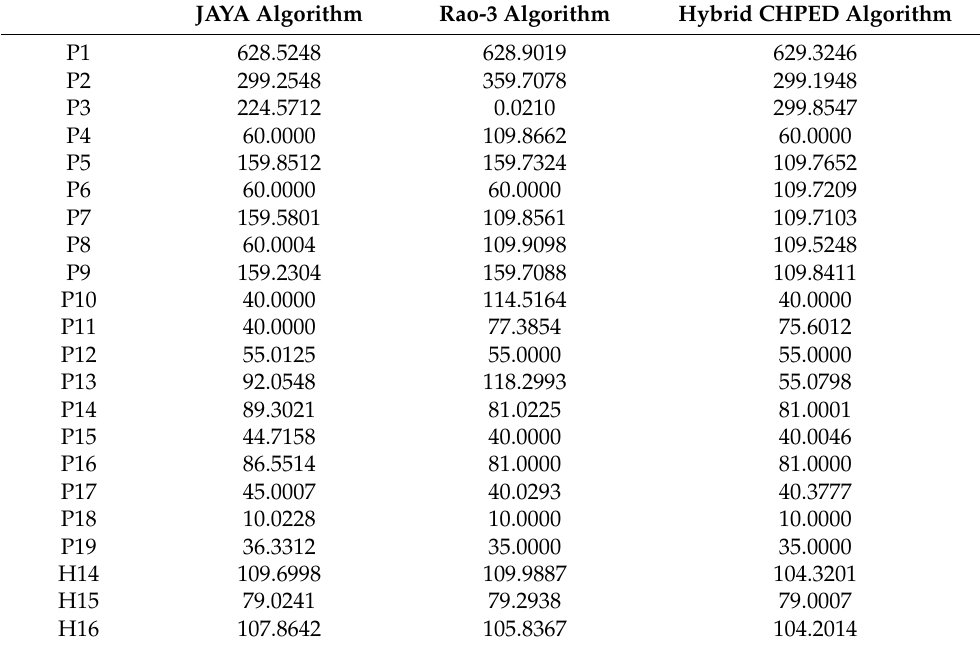
Table 5. Optimised values of the power-heat production for case 2 of test system 2. JAYA Algorithm Rao-3 Algorithm Hybrid CHPED